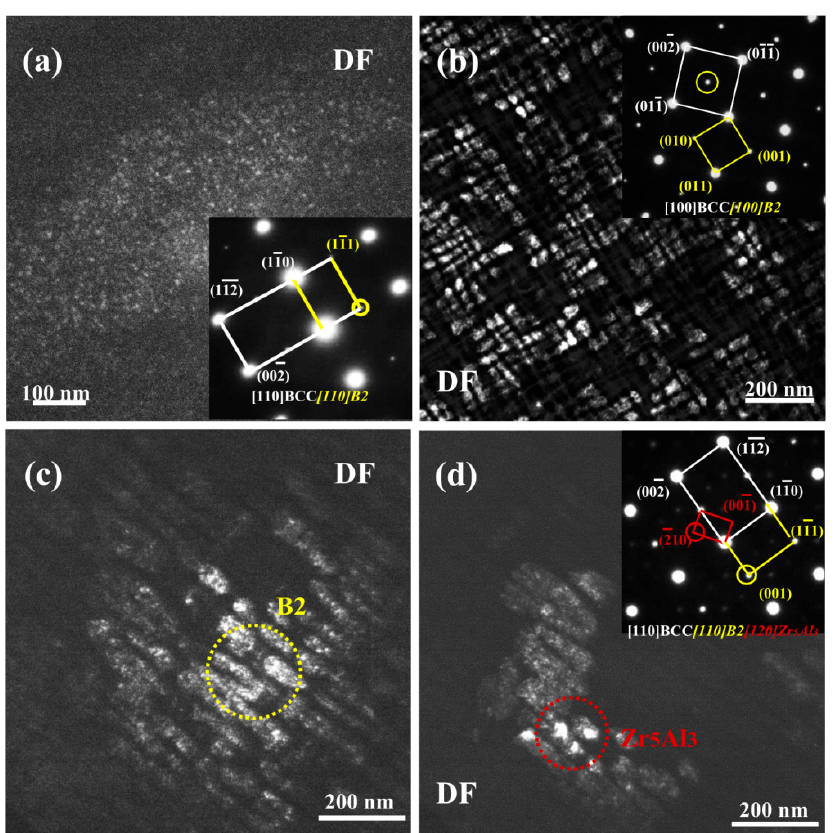
Figure 3. TEM characterization of S3 RHEA in solid-solutioned ( a ) and 873 K-aging ( b – d ) states. tEM dark field (DF) images ( a ) and corresponding SAED patterns along the [110] BCC axis; TEM dark field (DF) images ( b ) and corresponding SAED patterns along the [100] BCC axis; TEM dark field (DF) images ( c , d ) and corresponding SAED patterns along the [110] BCC axis for the corresponding SAED patterns.